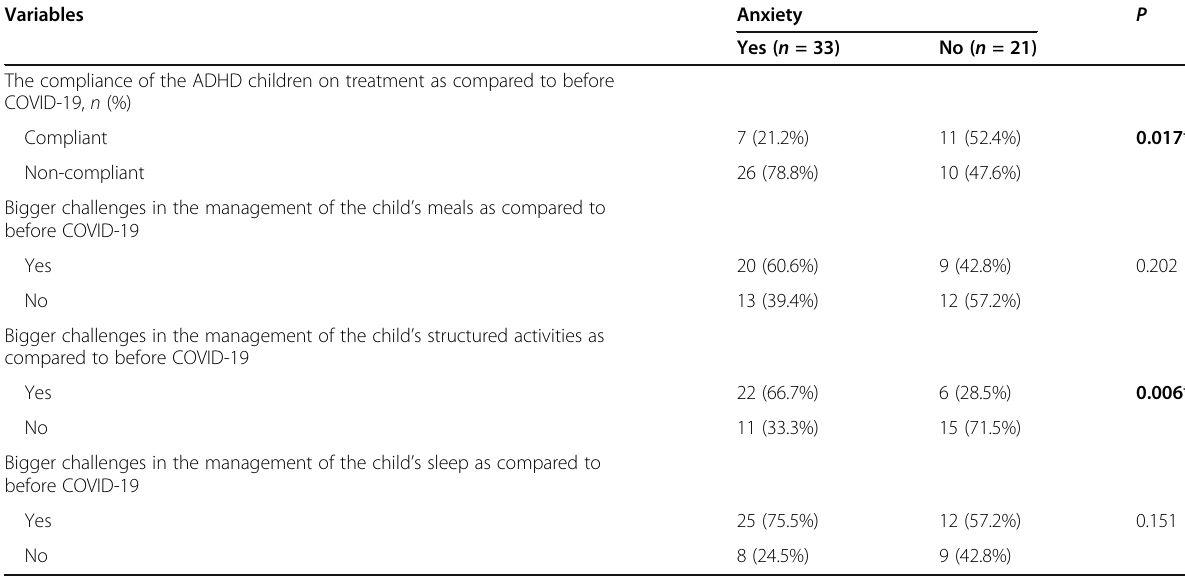
Table 4 Association between anxiety and other characteristics in mothers of ADHD children (Continued)